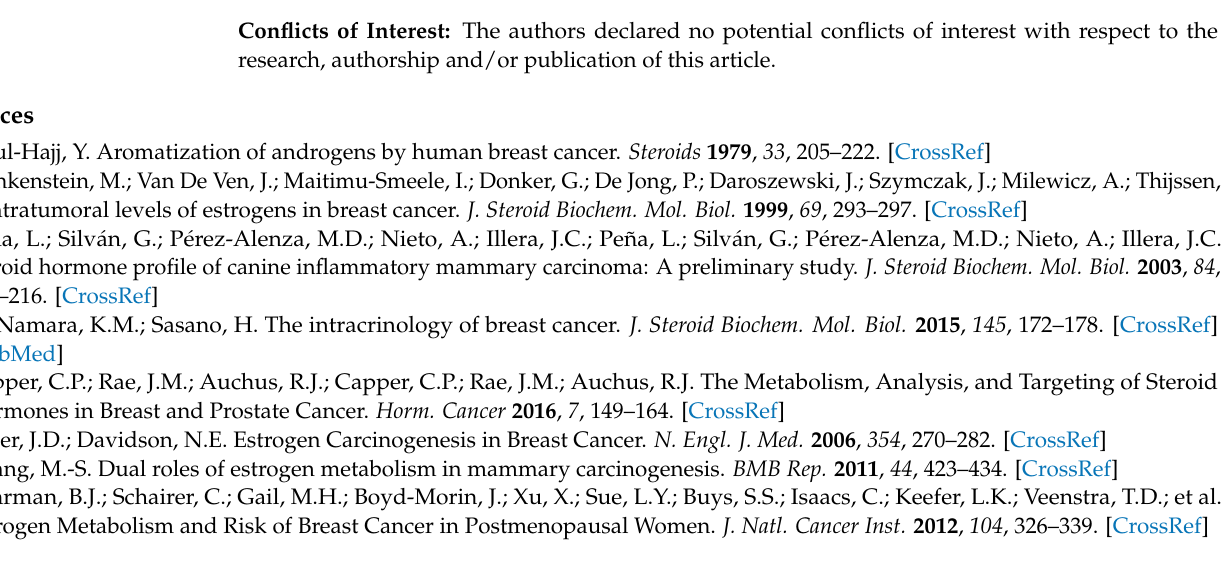
Table S2: Steroid concentrations (P4, DHEA, A4, T, DHT, SO1E4 and E2), angiogenic growth factors (VEGF-A, VEGF-C, VEGF-D) and IL-8 concentrations in tumour homogenate (H) and serum (S) in IPC-366- and SUM149 xenografted mice after (a) VEGF, (b) SU5416, (c) bevacizumab and (d) celecoxib treatments. Figure S1: In vivo effect of different dosages of VEGF, SU5416, bevacizumab and celecoxib on tumour growth in each individual IPC-366 xenotransplanted mice ( n = 5 mice per dosage of treatment). Figure S2: In vivo effect of different dosages of VEGF, SU5416, bevacizumab and celecoxib on tumour growth in each individual SUM149 xenotransplanted mice ( n = 5 mice per dosage of